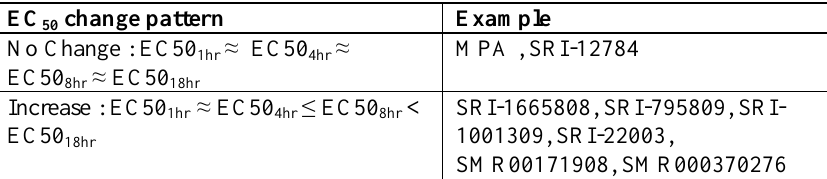
change depending on the time of 50